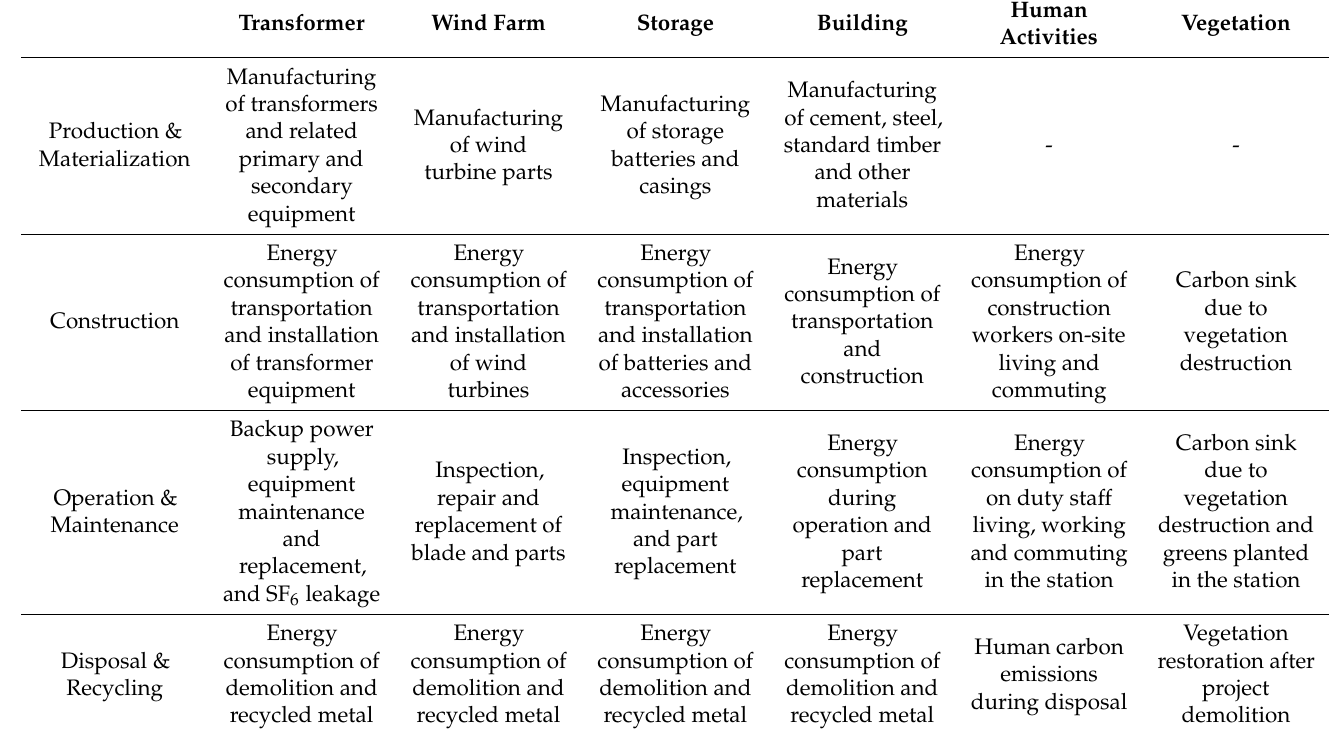
Table 3. Carbon footprint sources in the LCA of the wind power IES.